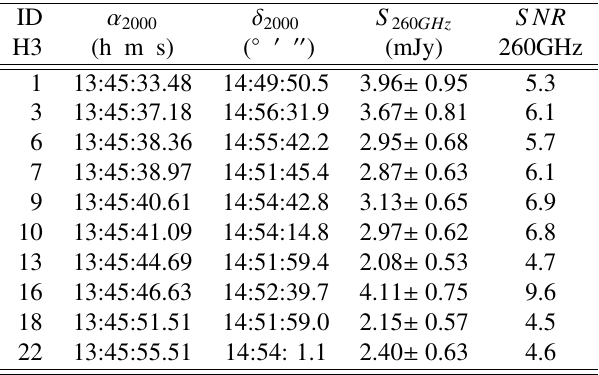
Table 1: NIKA2 astrometry and photometry of unambiguously detected sources at 1.15